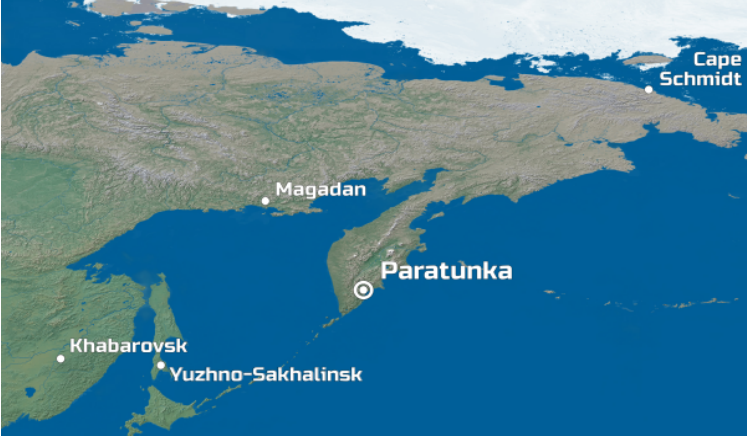
Figure 1. Location of the Paratunka observatory.